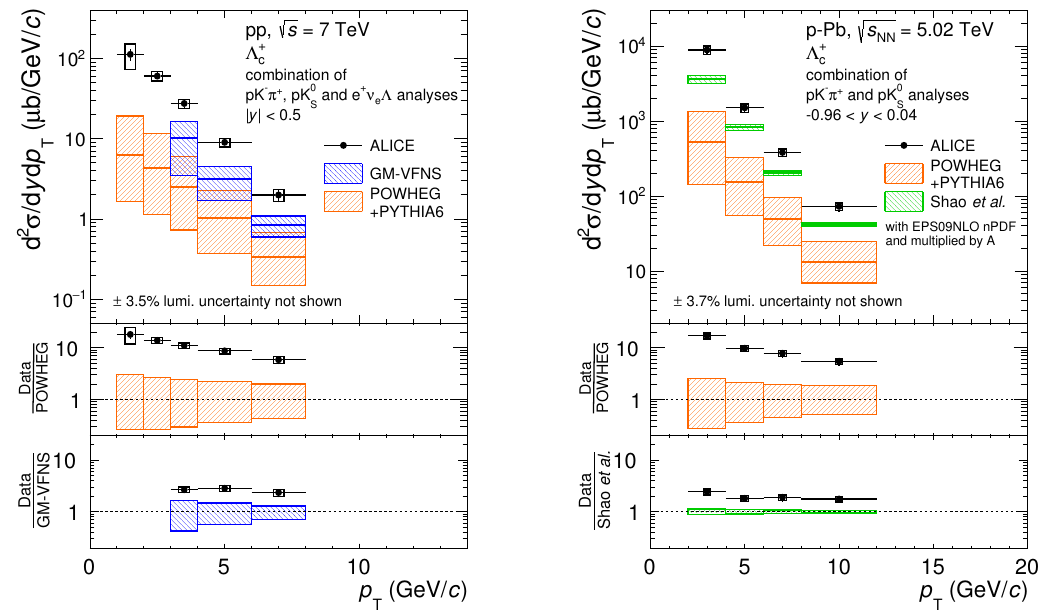
Figure 9 . Prompt (cid:3) + baryon p T -di(cid:11)erential cross section (average among di(cid:11)erent decay modes c p and analyses) in pp collisions at s = 7 TeV in the transverse momentum interval 1 < p T < p 8 GeV/ c (left) and in p-Pb collisions at s NN = 5 : 02 TeV in the transverse momentum interval 2 < p T < 12 GeV/ c (right). The statistical uncertainties are shown as error bars and the systematic uncertainties are shown as boxes. See text for details of the procedure to average the di(cid:11)erent decay channel measurements reported in (cid:12)gure 8. Comparisons with GM-VFNS calculations [1, 2], powheg event generator [9] and with Lansberg and Shao predictions [94] for p-Pb (see text for details) are also